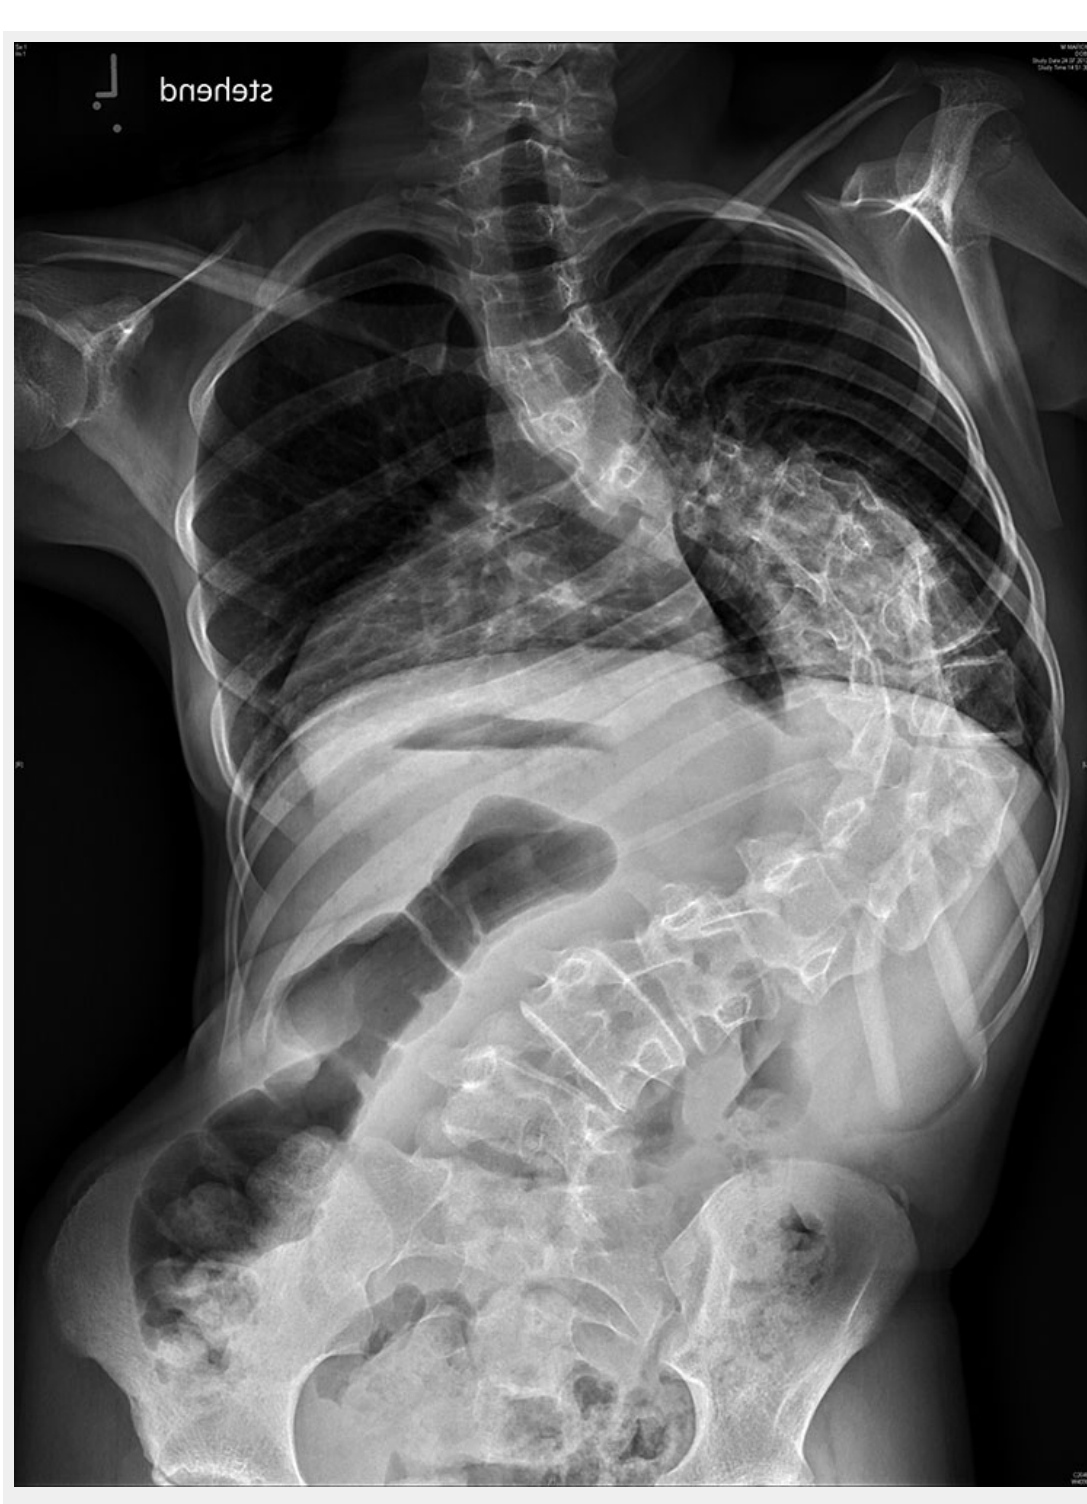
Figure 1 A 12-year old otherwise healthy girl with an idiopathic adolescent scoliosis: 130° right convex thoracic curve wit elevation of the right shoulder and pelvic asymmetry. The patient and her family seeked a doctor’s advice because of a prominent right thorax (rib hump) and a flattened right waist line. Pain was not an issue, nor was there any neurological